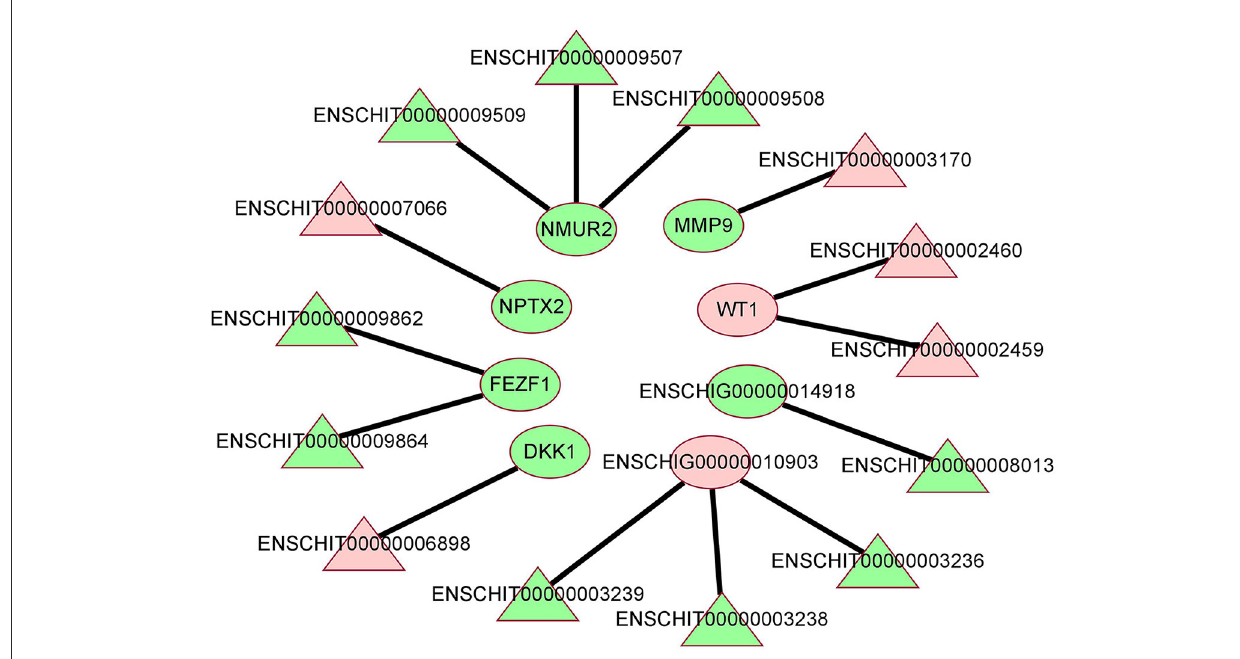
FIGURE4 The co-expression network of lncRNA and mRNA between HFG and LFG in the hypothalamus. The red color represents upregulated expression, the green represents downregulated expression, the triangle represents lncRNA, and the ellipse represents mRNA.